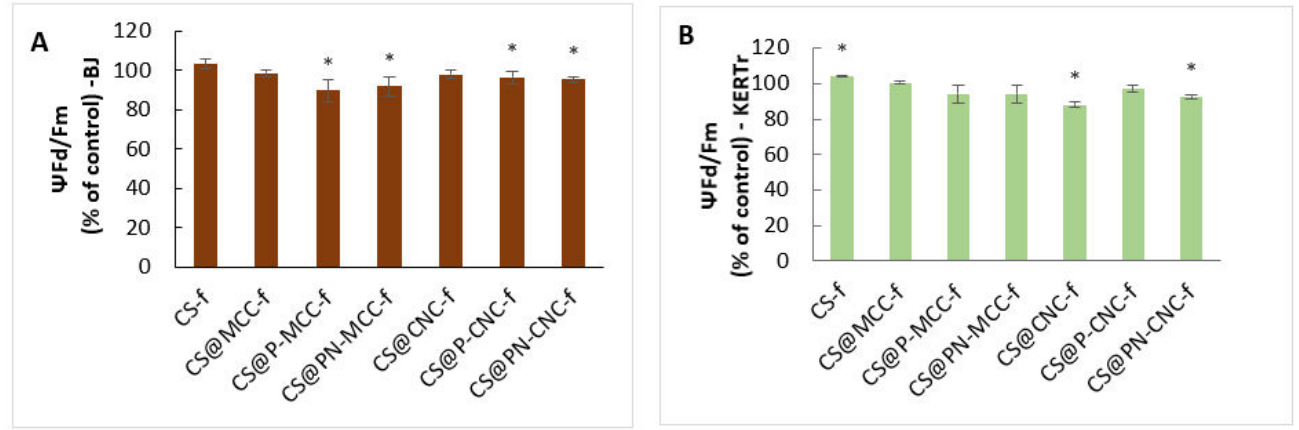
Figure 6. The transmembrane mitochondrial potential ( ∆Ψ m) of BJ ( A ) and KERTr ( B ) incubated for 24 h with chitosan- cellulose biocomposites, n = 6. * p <